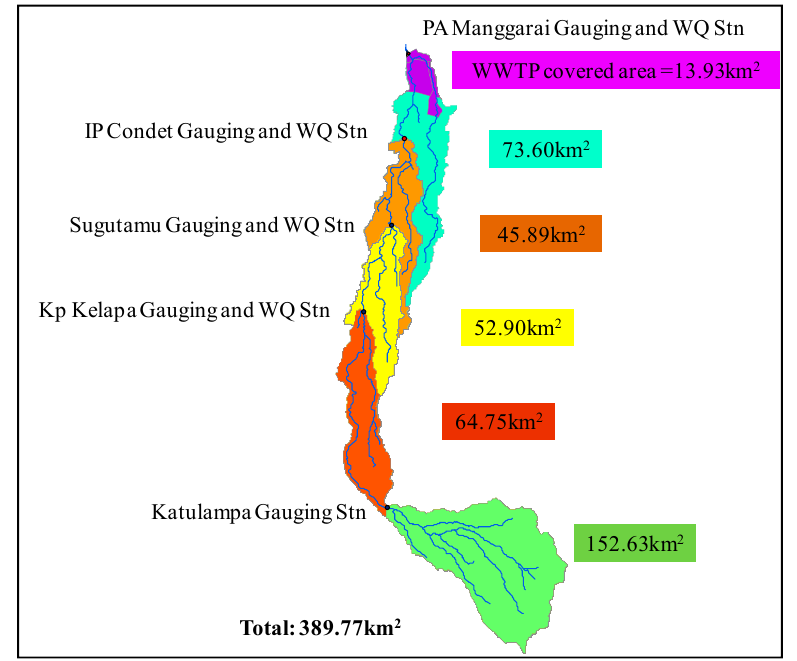
Figure 2. The Ciliwung River network with sub-catchments and locations of wastewater treatment plants, water quality stations, and streamflow measurement stations. WWTP: wastewater treatment plant. (Here- WQ Stn—Water Quality Station).